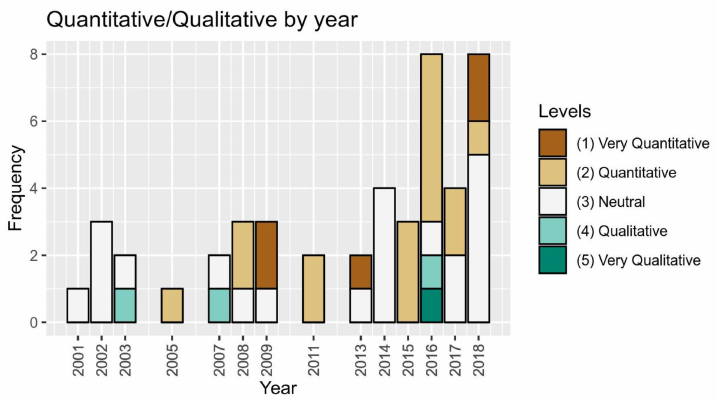
Figure 6. Frequency of sources based on levels of quantitative/qualitative dimension over the past 20